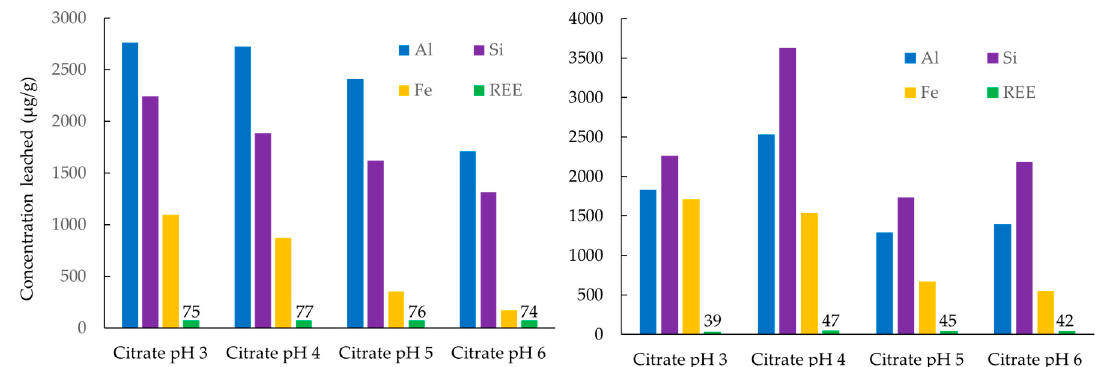
Figure 5. Concentration of Al, Si, Fe, and REE in PLS generated by citrate solution at different pH values for underclay sample UC-02 ( left ) and UC-03 ( right ). Values are converted to micrograms of element leached into PLS per gram of underclay (µg/g).